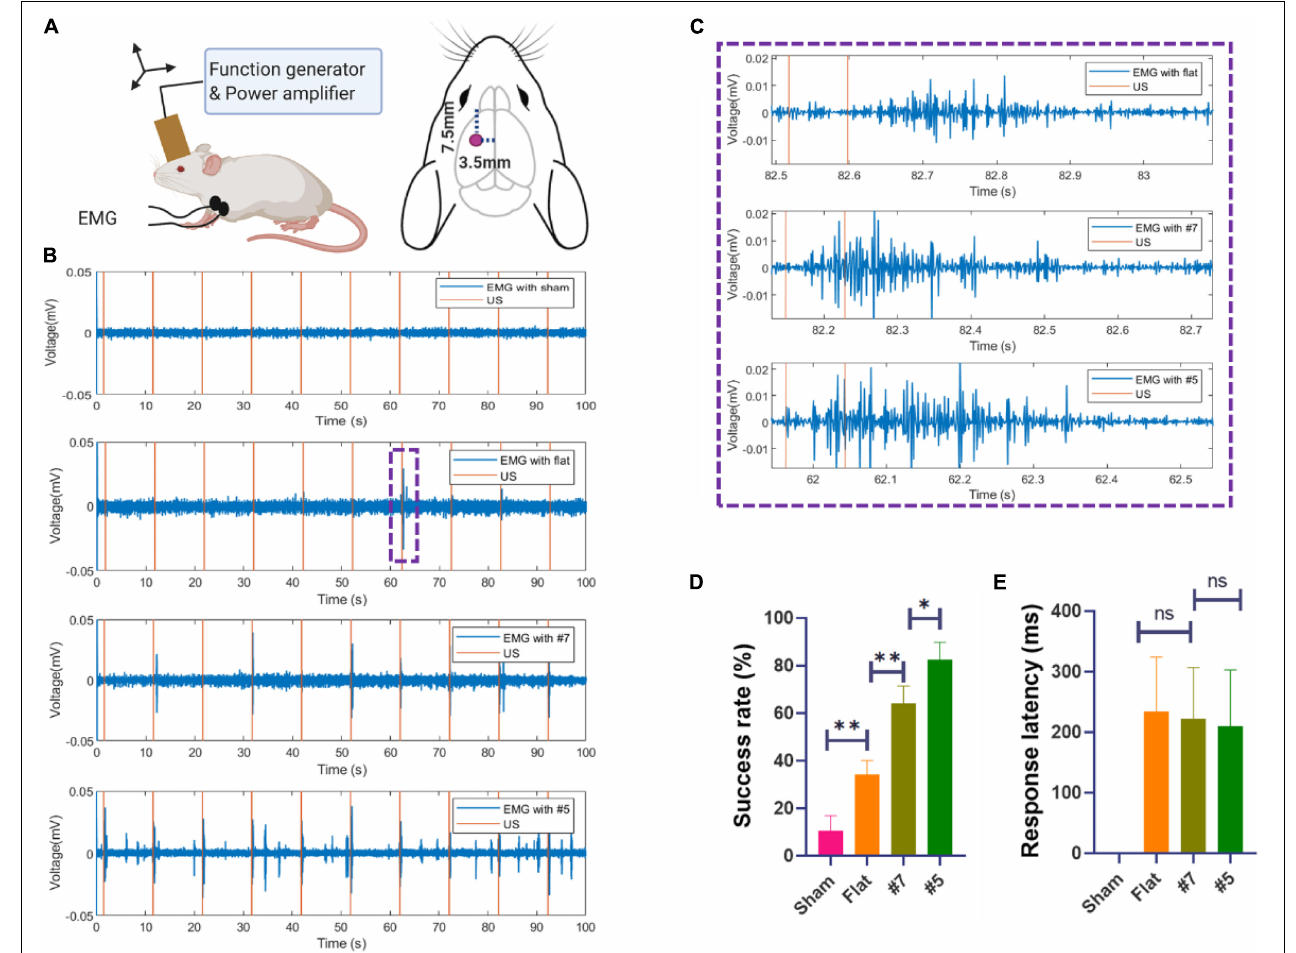
FIGURE 9 | (A) Schematic diagram of in vivo mouse EMG recordings using ultrasound neuromodulation to the motor cortex. (B) Example sync pulses (orange) and EMG responses (blue) resulting from sonication with sham, flat transducer, focused transducer #7.5, and #5 at 1.6 MPa. (C) Representative EMG signals induced by a single trial, zooming from (B) . (D) The success rate of ultrasound evoked responses and the response latencies (E) sonicated by sham, flat, focused transducer #7.5, and #5 ( N = 6, 20 trials/animal, ∗ p < 0.05, ∗∗ p < 0.01, one-way ANOVA with post-hoc Tukey test. All statistically significant differences are